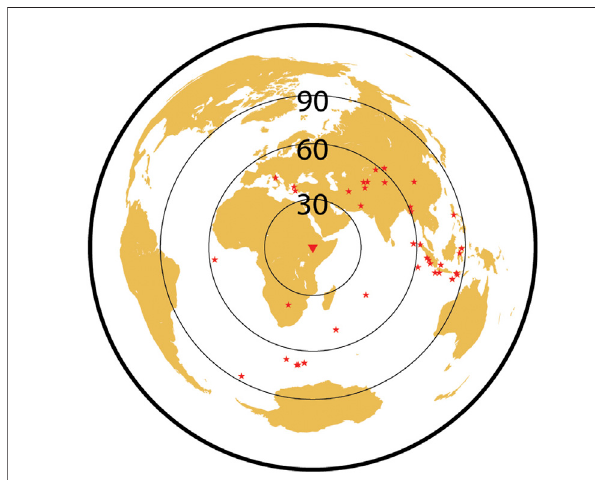
FIGURE 2 | Red circles are locations of the teleseismic earthquakes used for the study. The data collected are in the distance ranging from 30 ° to 90 ° inthetimerangeofFebruary2016toOctober2017.Thedarkbluetriangle is the central location of the 17 seismic stations used in this